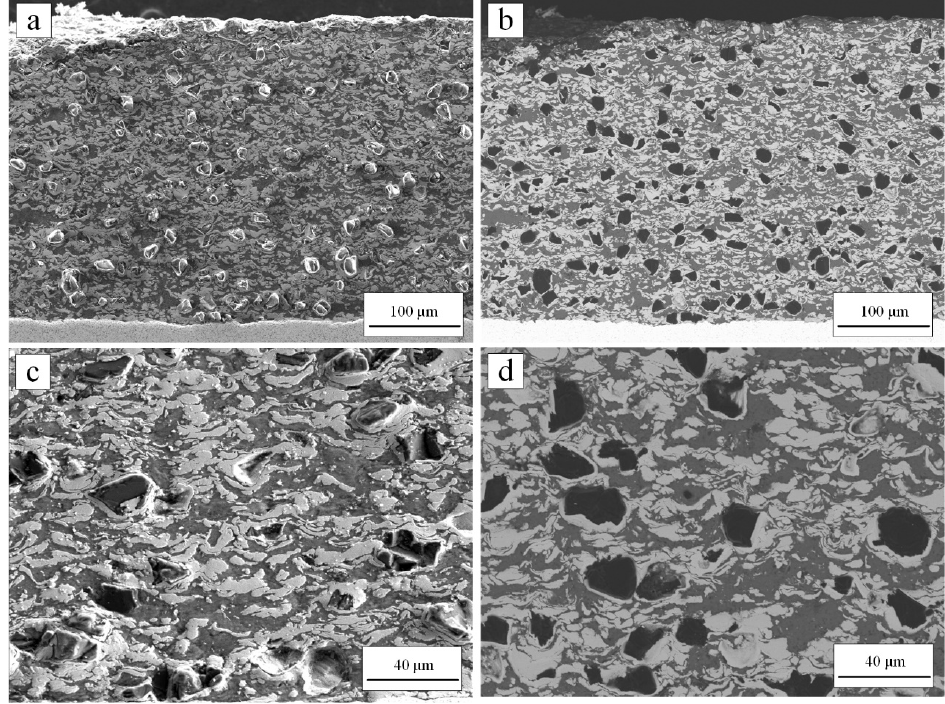
Figure 4. SEM images of the cross-section of diamond/Ni/Al coating at the magnification of 150× ( a , b ), and 500× ( c , d ): ( a , c ) were taken in SE imaging mode, showing the morphology of the cross-section; ( b , d ) were taken in BSE imaging mode, showing the content and distribution of diamond/Ni/Al.